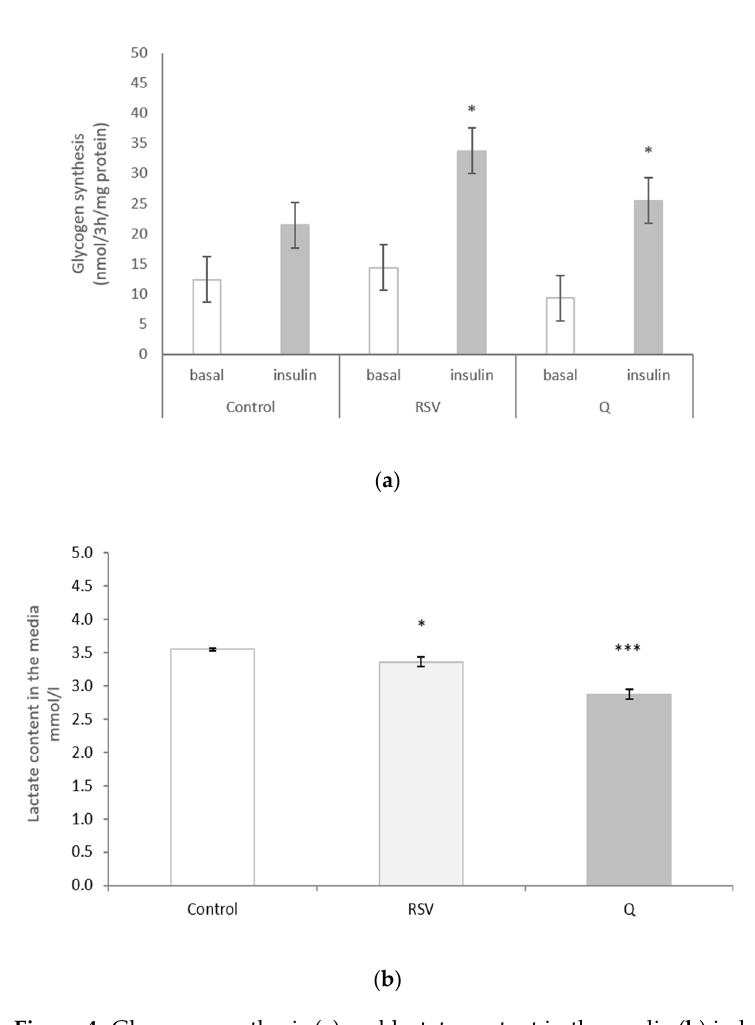
Figure 4. Glycogen synthesis ( a ) and lactate content in the media ( b ) in human myotubes treated with 0.1 μM of resveratrol (RSV) and 10 μM of quercetin (Q) for 24 h. Glycogen synthesis data are presented as the mean ± SEM of three biological replicates. The data of lactate content in the media are presented as the mean ± SEM of six biological replicates. Comparisons between each treatment group and the control group were analysed by Student’s t -test. The asterisks represent differences versus the controls ( * p < 0.05; ( *** p < 0.001)).